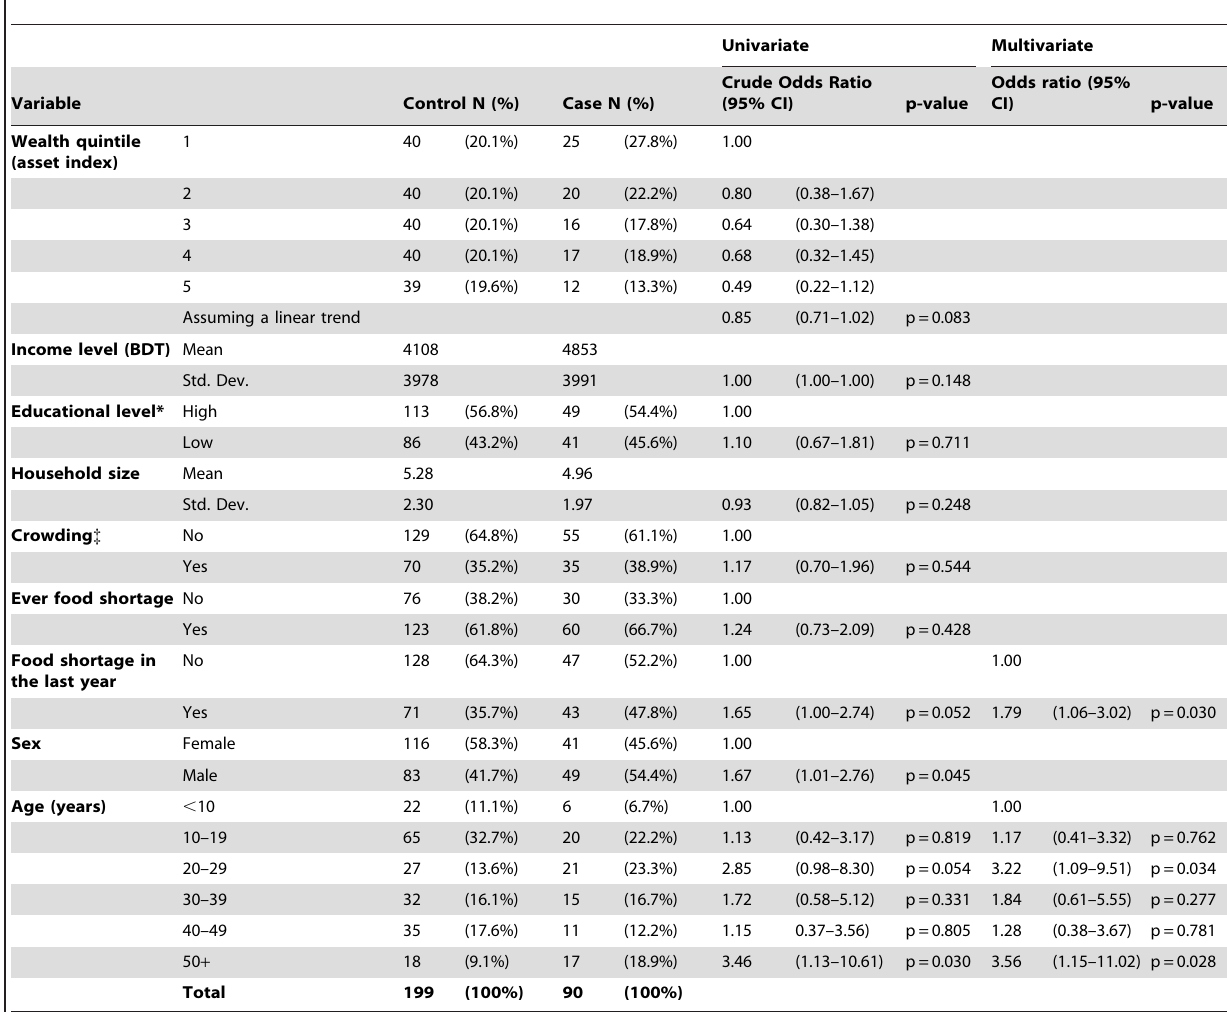
Table 3. Results of univariate and multivariate logistic regression analysis with a backwards elimination